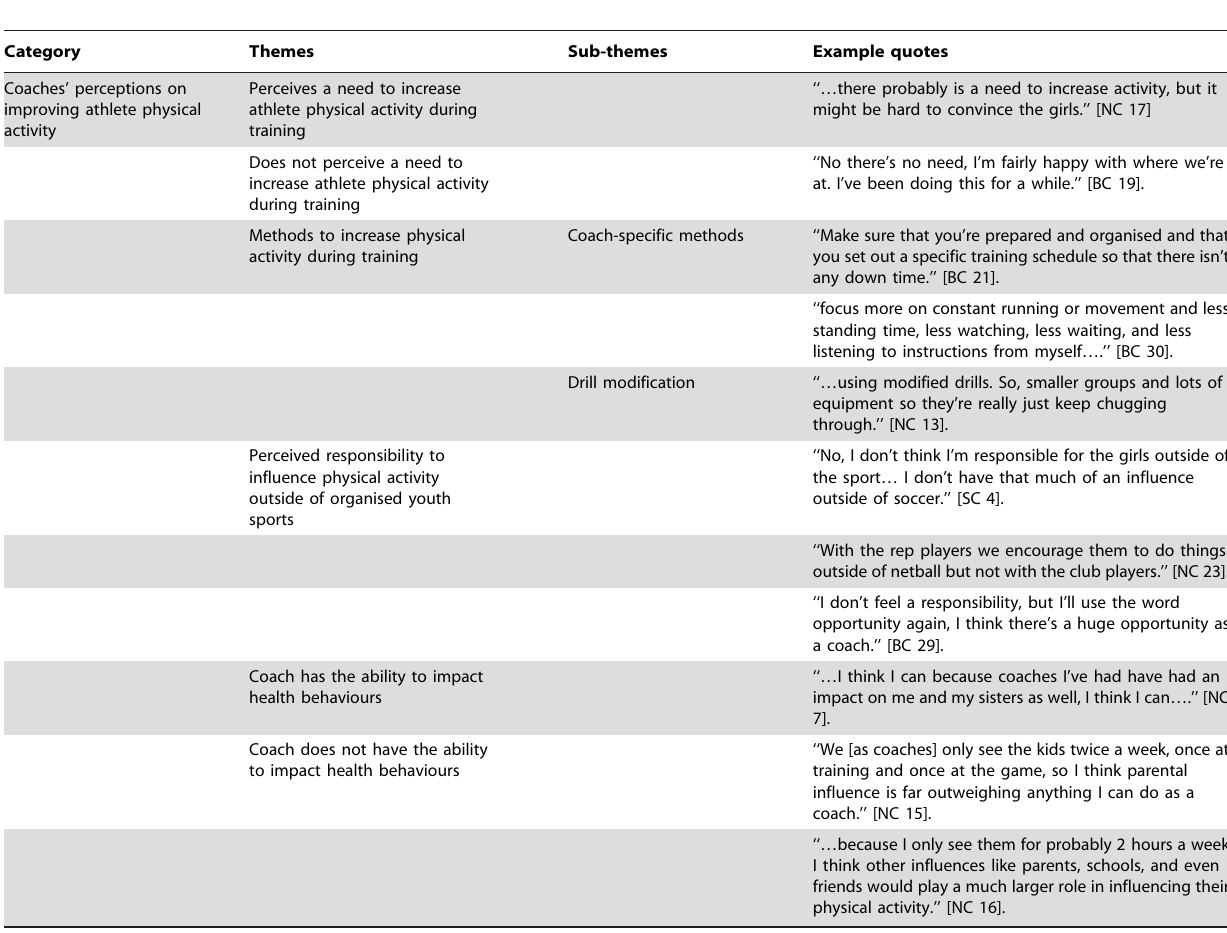
Table 6. Coaches’ perceptions on improving athlete physical activity: summary of categories, themes, sub-themes, and example